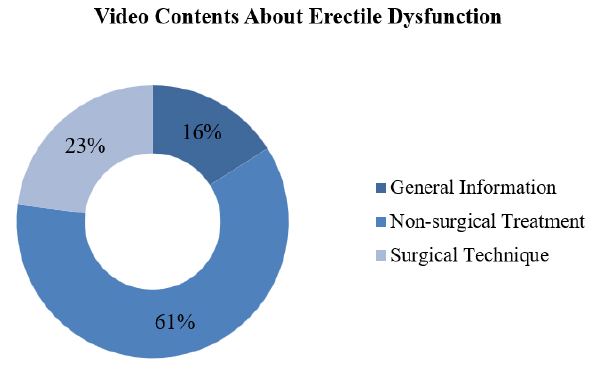
Fig. 3. Contents of the reviewed YouTube videos.